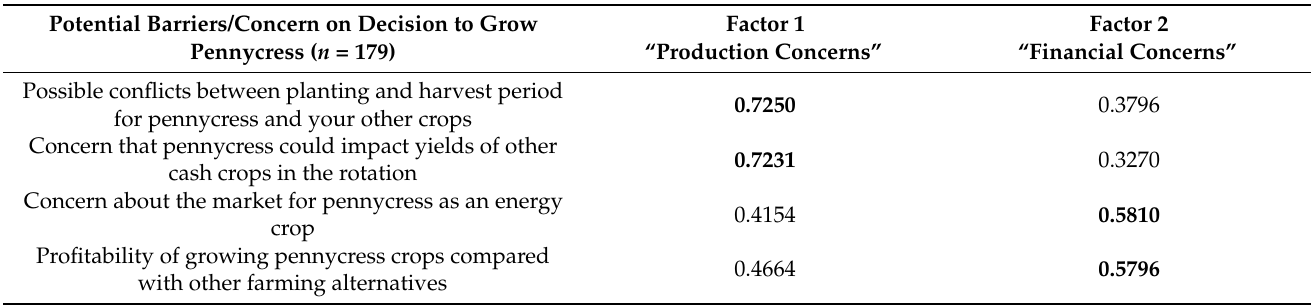
Table 3. Factor loadings for importance of potential concerns/barriers on decision to grow pennycress among crop farmers surveyed in seven US states.